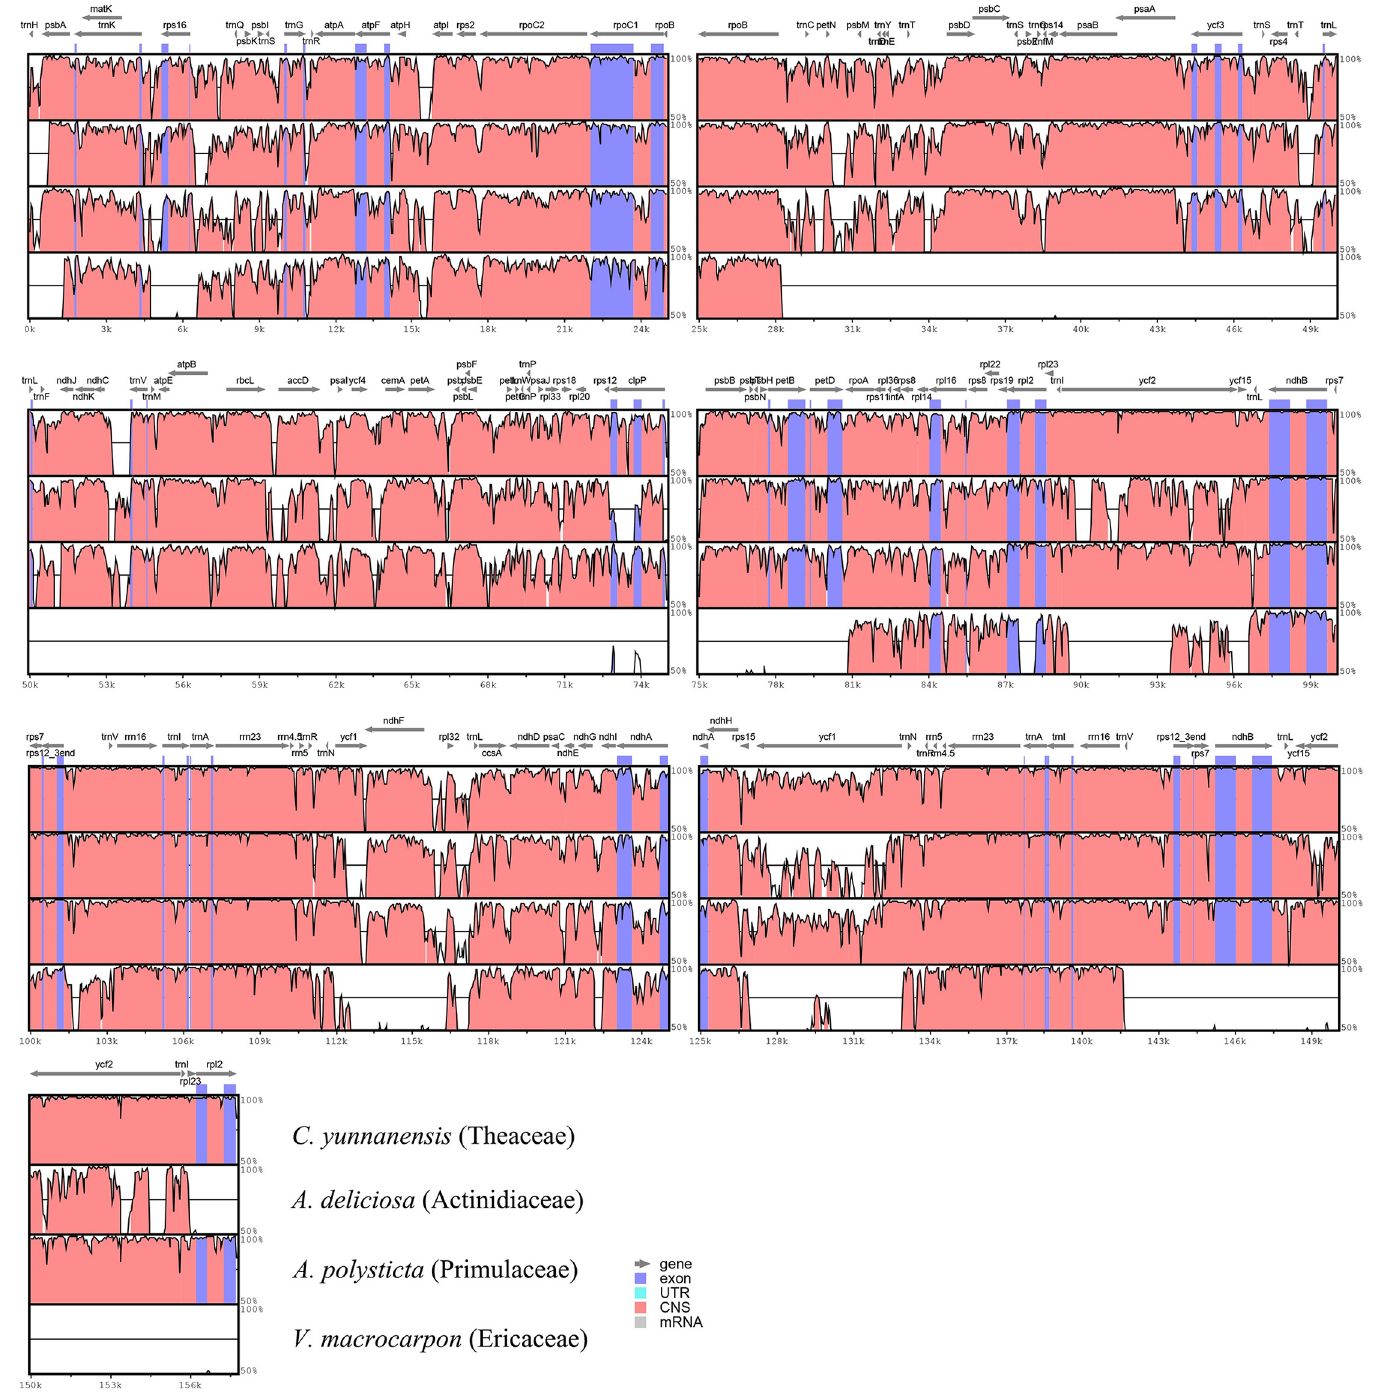
Fig 2. Global alignment of Ebenaceae genome and other published chloroplast genomes in Ericales using VISTA. Y-axis indicates the range of identity (50% – 100%). Alignment was performed using D. kaki as a reference.